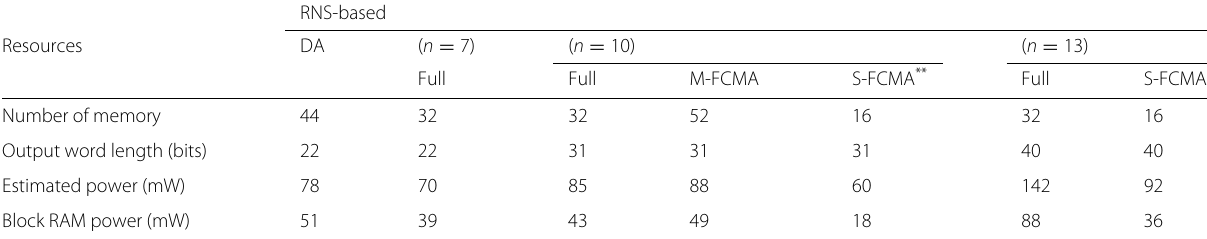
Table 6 The effect of using four memories in each filter-tap with ZC706 RNS-based